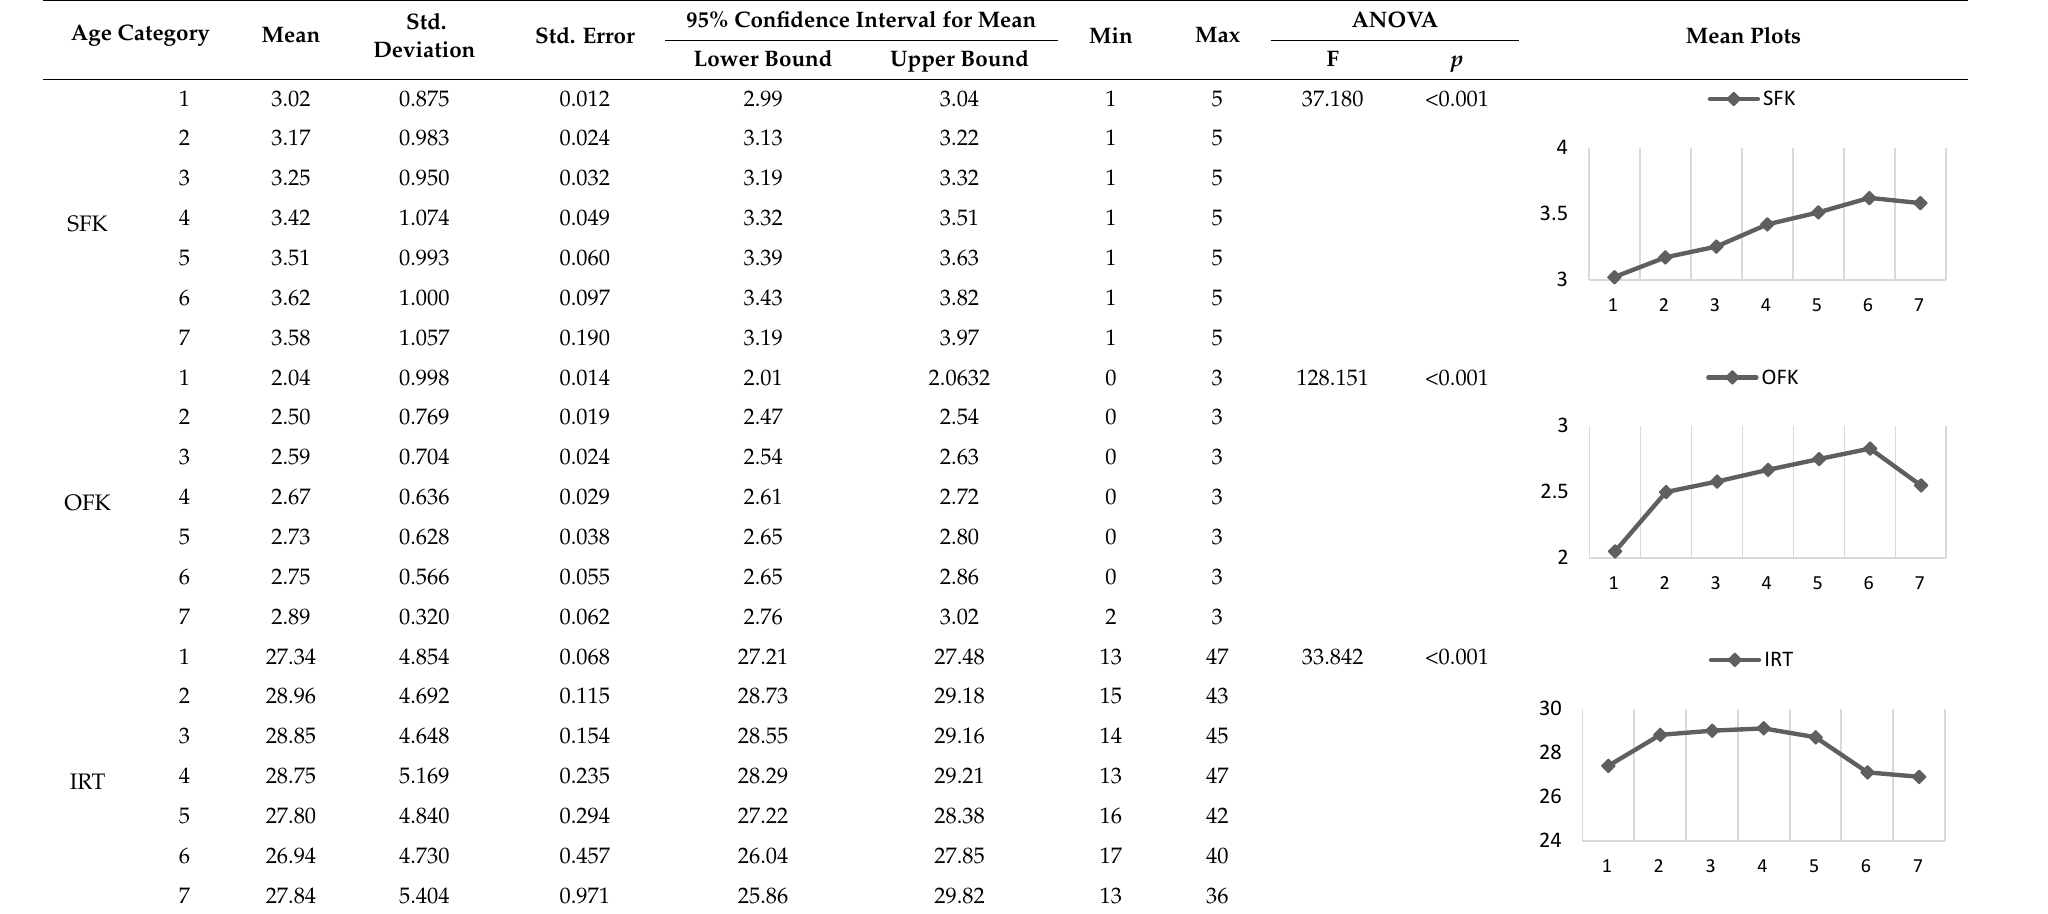
Table 4. Financial Knowledge and Investment Risk Tolerance Comparisons Across Age Categories (N = 8038).